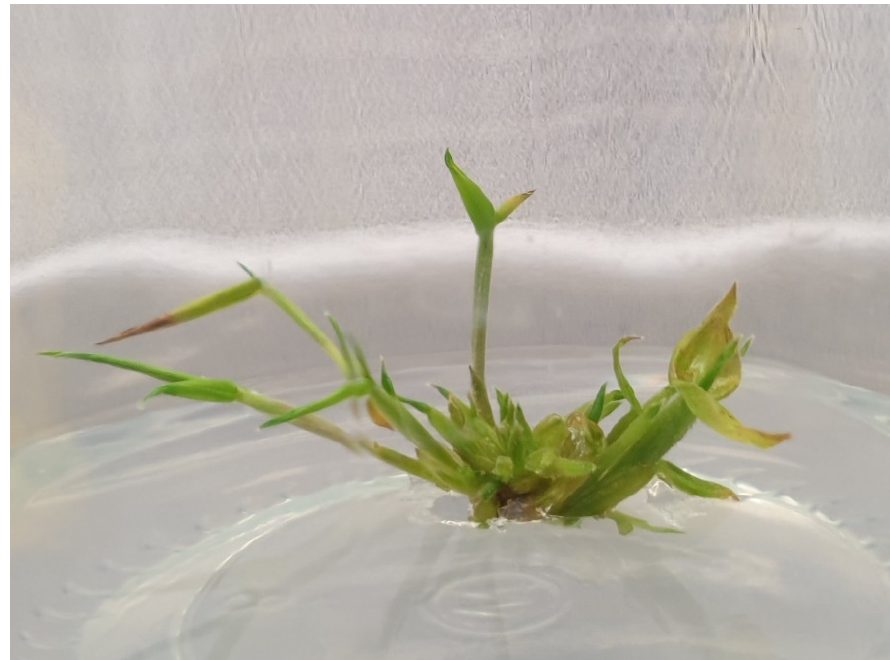
Figure 2. Micropropagation of D. asper using a seeds explant. Shoot multiplication in Murashige and Skoog basic medium (MS) + 2 mg/L BAP.